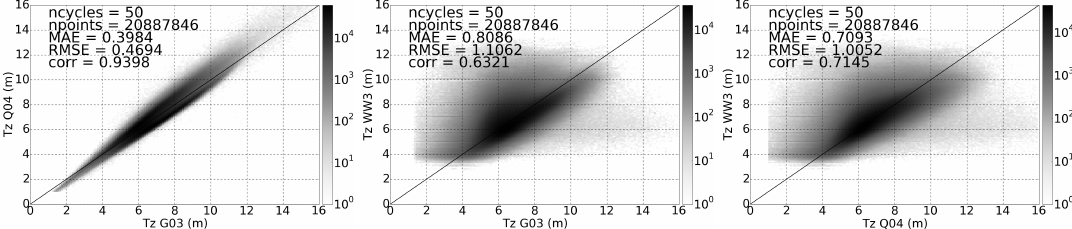
Figure 2. Statistical analysis of mean wave period algorithms G03, Q04 and the Tz derived from numerical wave model WW3 (from left to right), for the first 50 cycles of Jason-1. All plots displaying the number of validated measurements, mean absolute error (MAE), root mean square error (RMSE) and correlation between measurements.